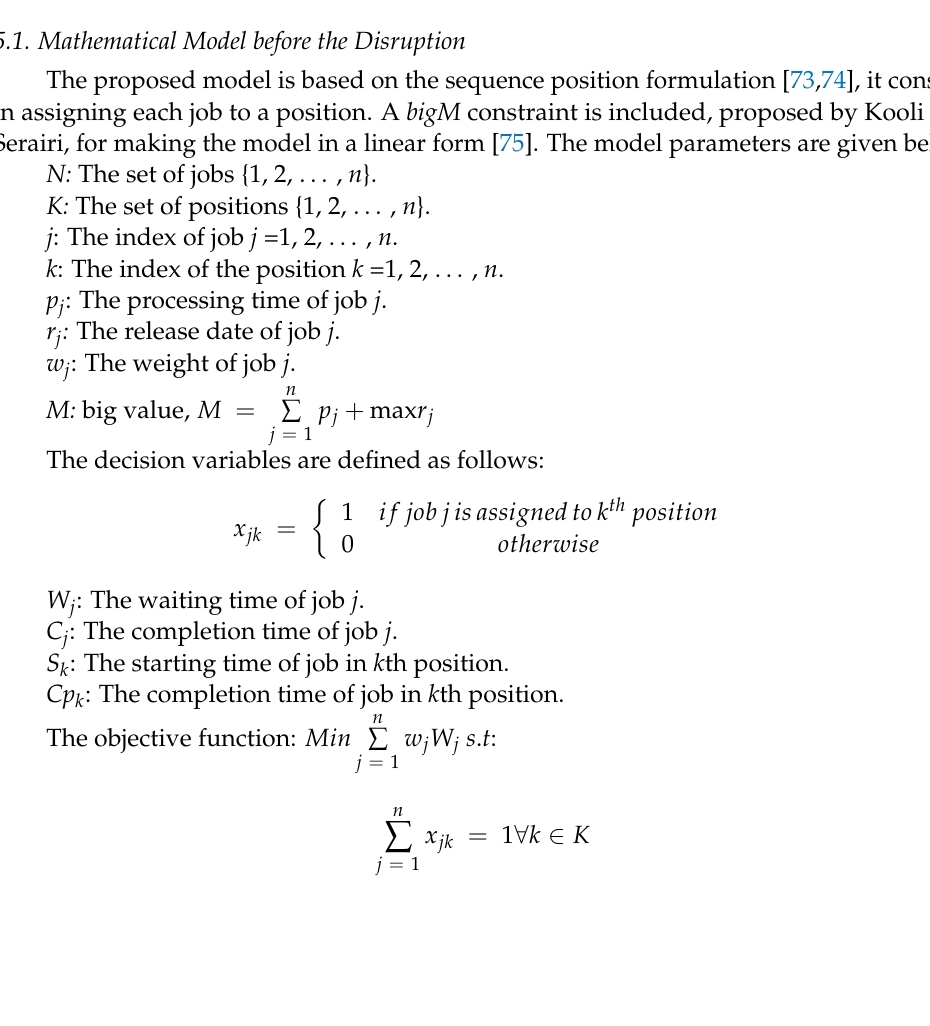
Figure 3. The flowchart of the proposed strategy.